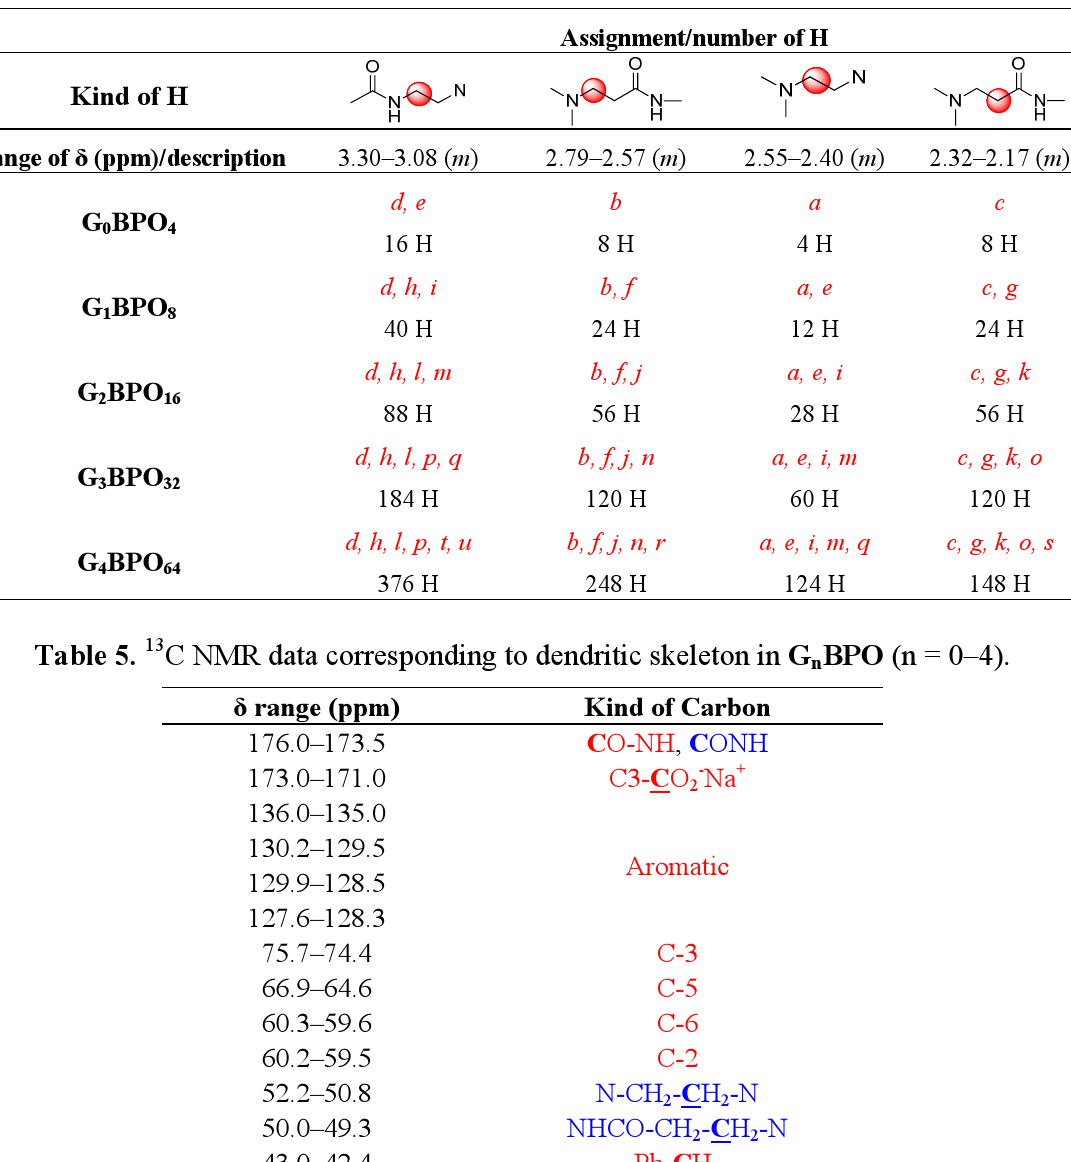
BPO (n = 0–4). n Assignment/number of H